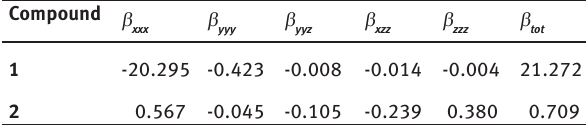
Table 3: Some selected components of the static b(0;00) and b (0;00) ( × 10 -30 esu) values for 1 - 2 computed by DFT method at tot B3LYP/ 6-31G( d ) level.